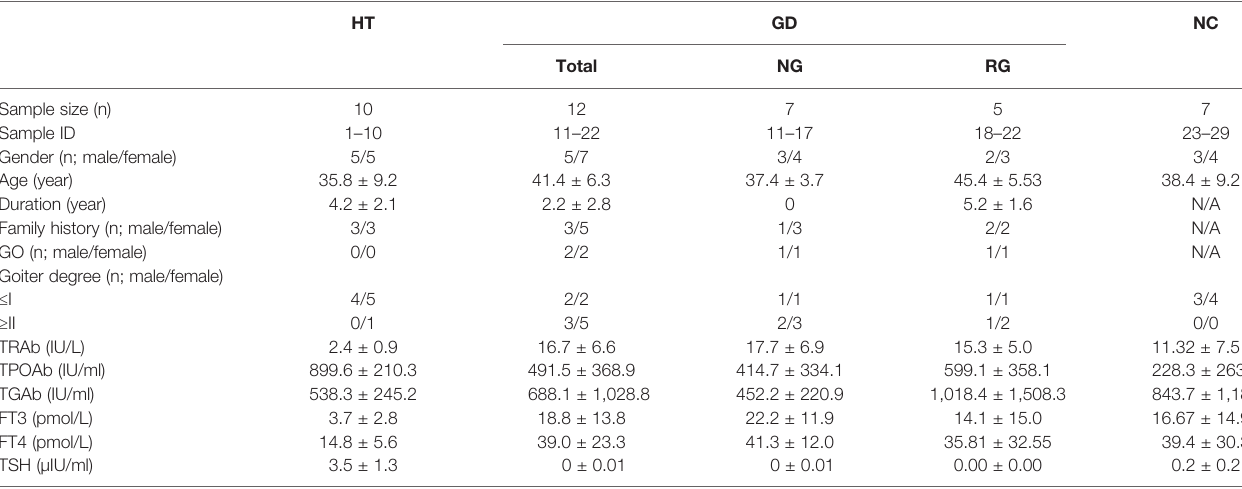
TABLE 1 | Clinical characteristics of all